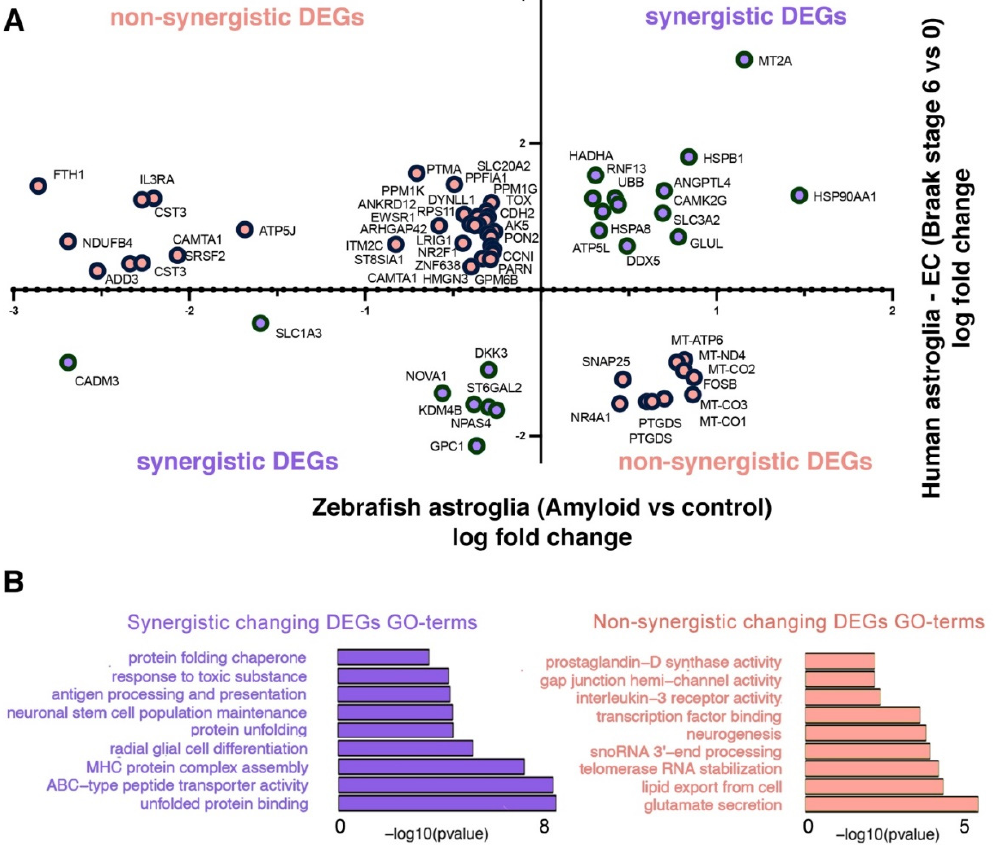
Figure 7. Comparison of differentially expressed genes in the human and zebrafish astroglia clusters. ( A ) Chart indicating the genes that are differentially expressed in astroglial clusters 2 and 4 in zebrafish (telencephalon, amyloid toxicity versus control) and human brains (entorhinal cortex, Braak stage 6 versus 0) when these clusters are compared within. The x-axis shows the log-fold changes for zebrafish astroglia and the y-axis denotes the log-fold changes in human astroglia. Duplicate gene names indicate their appearance in both astroglial clusters. The gene names are distributed sterically on the graph. ( B ) Selected GO terms for synergistically and non-synergistically differentially expressed genes in all astroglial clusters, combined. See Datas S4, S5 and S12.